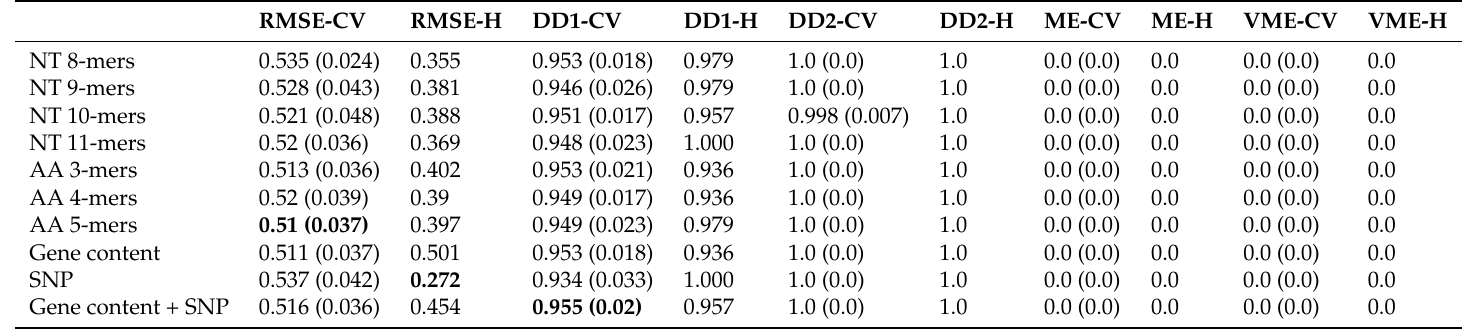
Table A20. C. jejuni